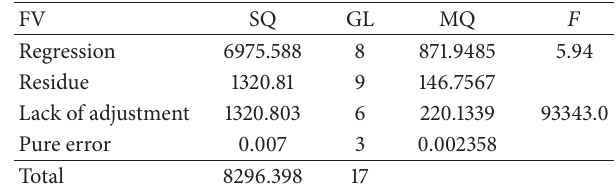
Figure 3: Response surface to tomato dehydration (thickness × temperature). Table 7: Coded values and corresponding actual values used in the third experimental design.